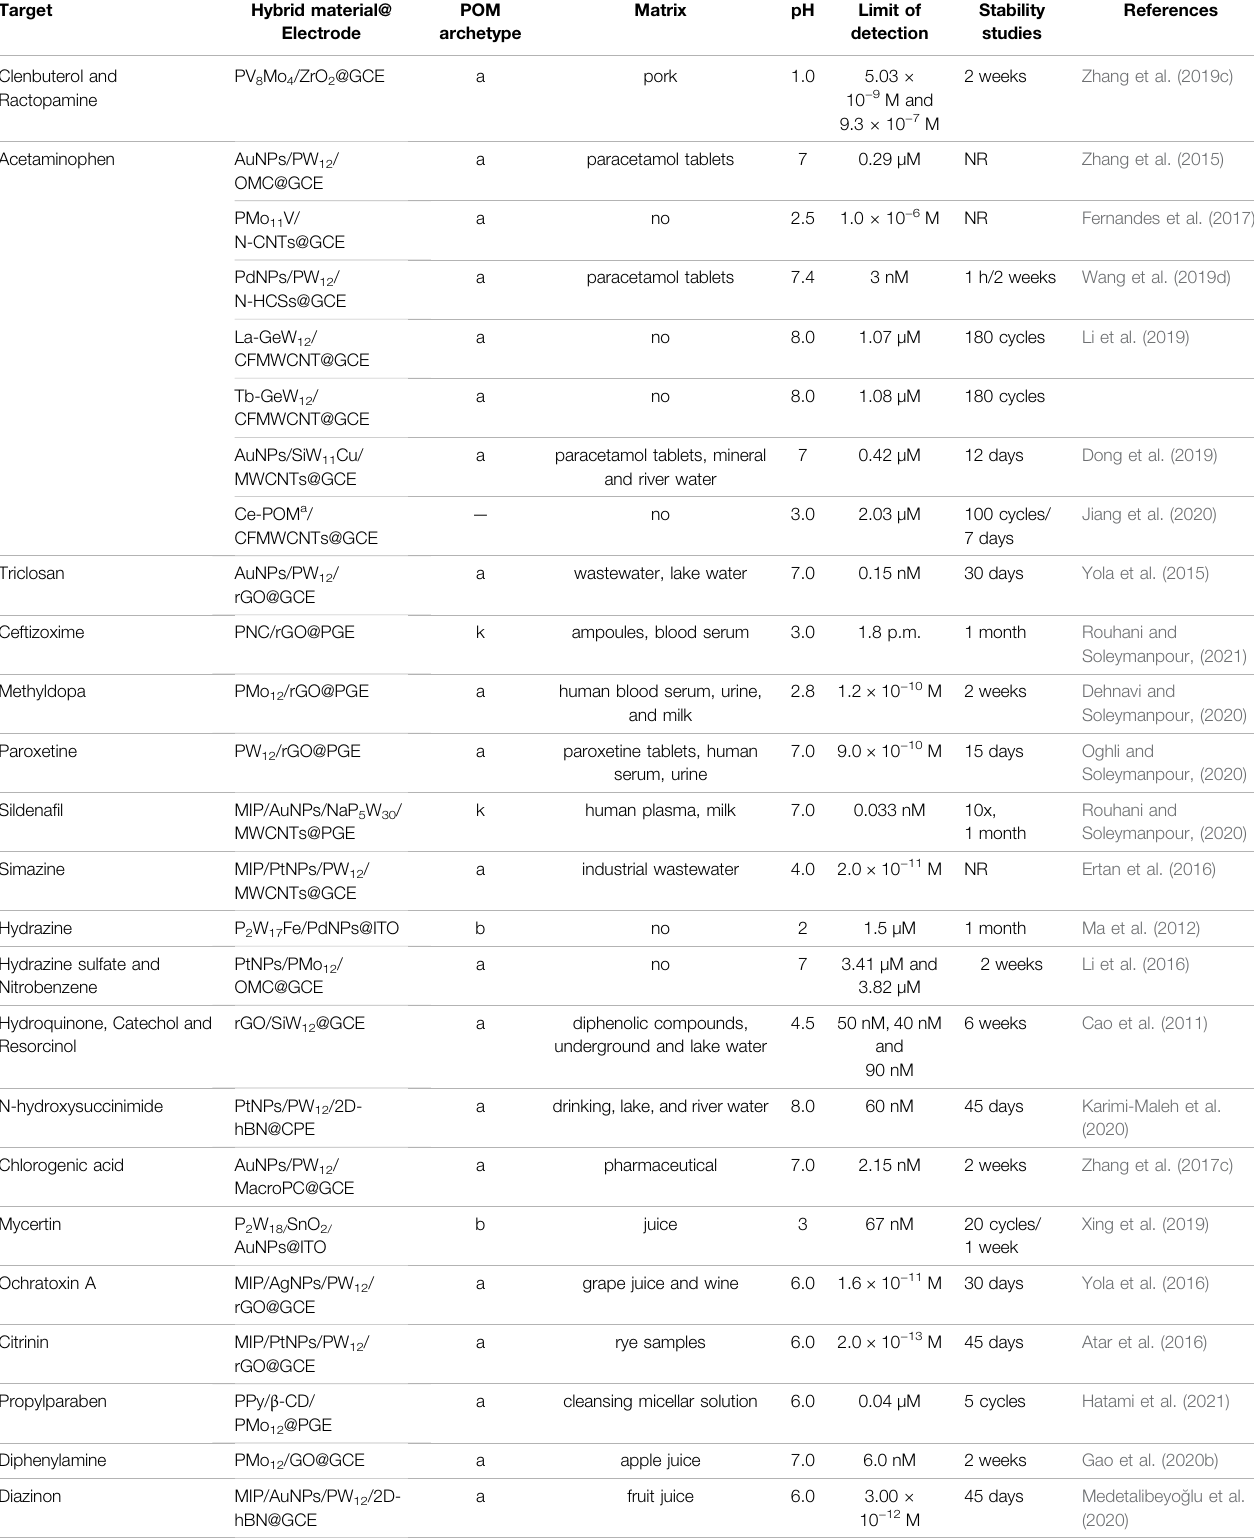
TABLE 5 | POM-based electrochemical sensors for medicines, pesticides, and toxic contaminants.